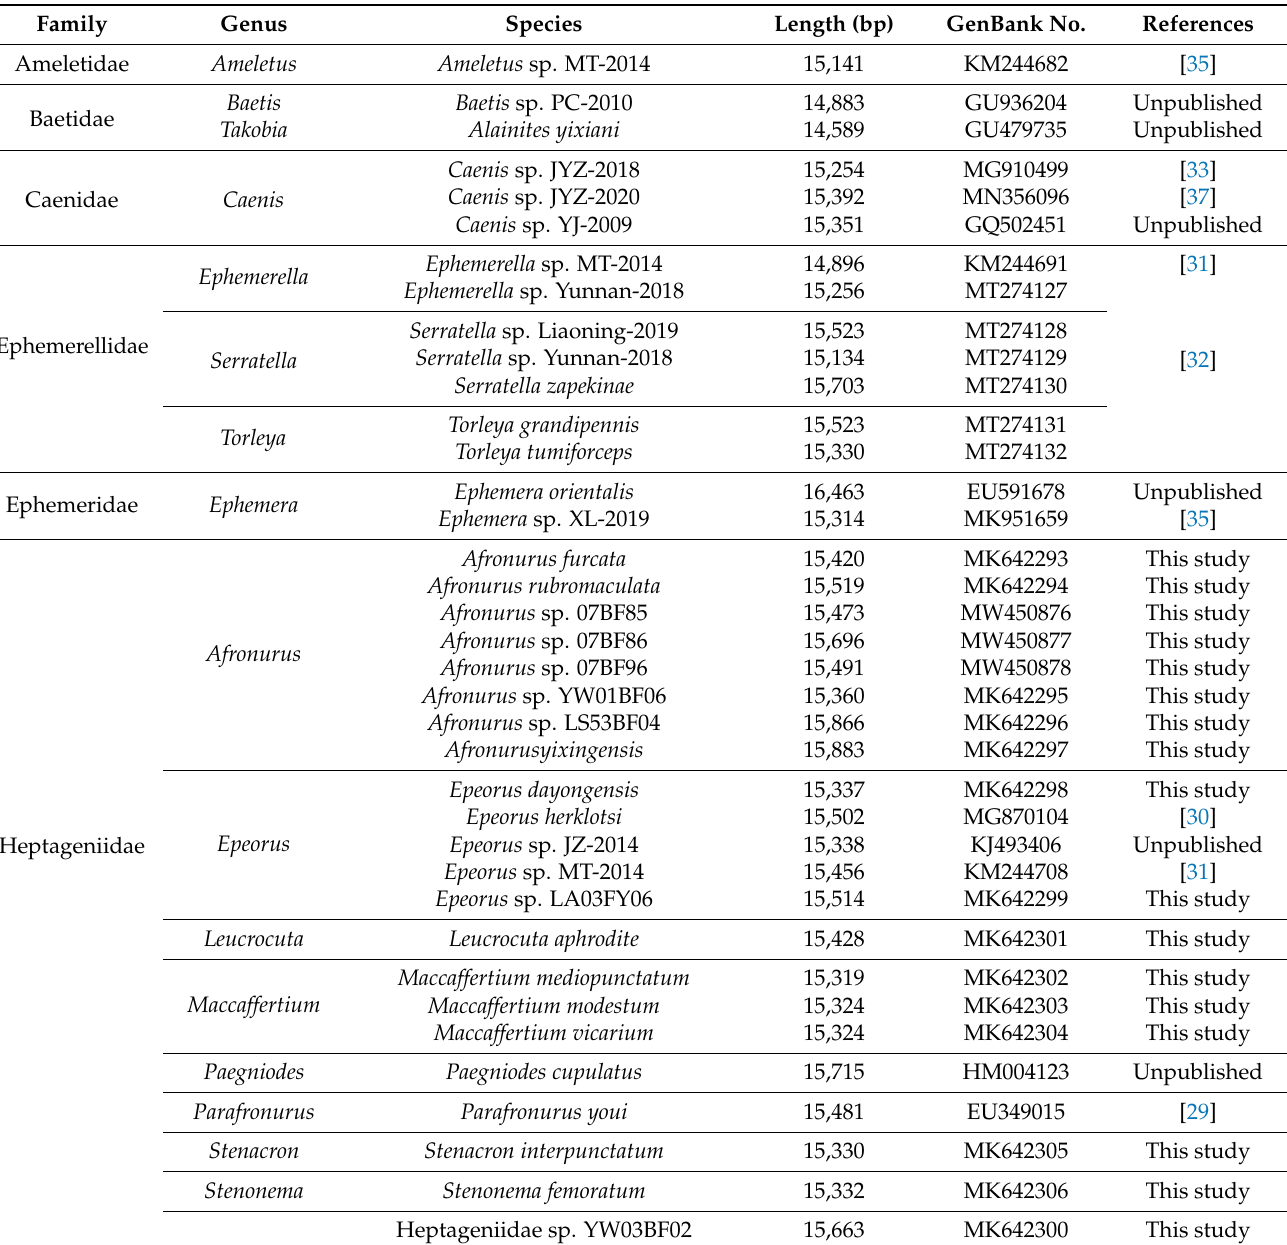
Table 2. List of Ephemeroptera mitogenomes used to construct phylogenetic